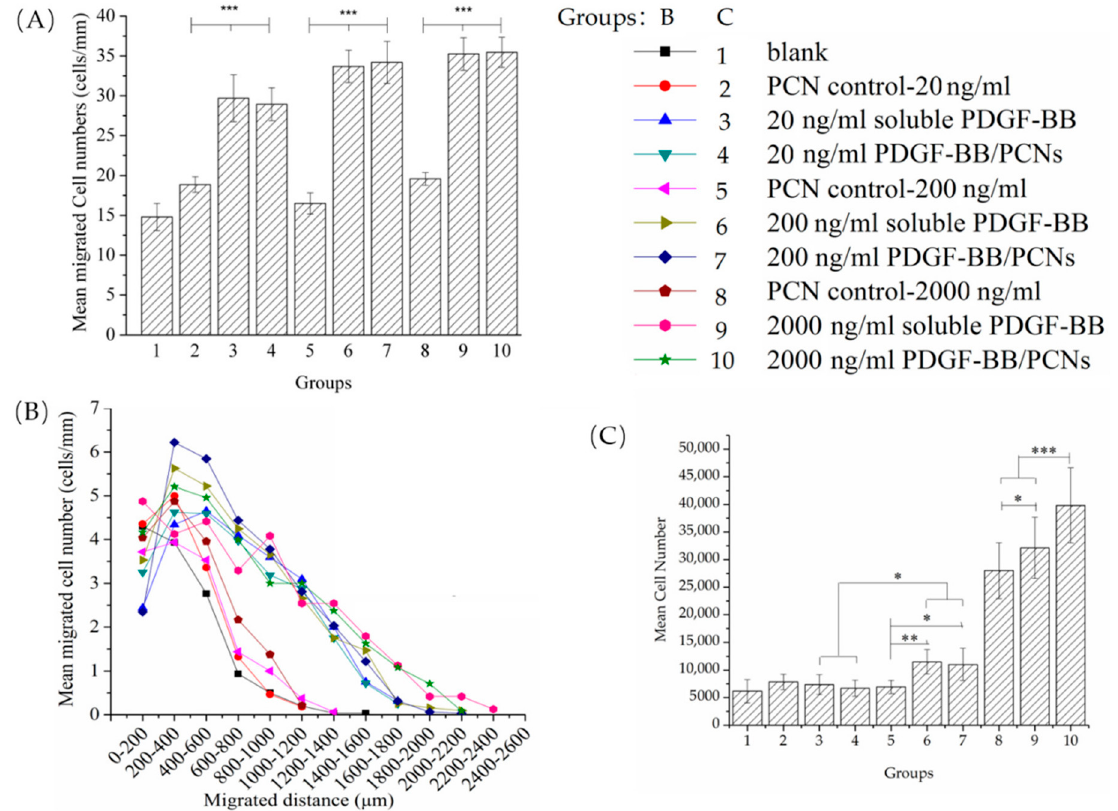
Figure 7. ( A ) Mean migrated cell numbers/mm of interface under the attraction of 20, 200 and 2000 ng/mL PDGF-BB, directly in gel or in PCNs; ( B ) Migration distance under different doses of PDGF-BB. ( n = 6~8; *** p < 0.001). ( C ) Cell numbers after 7 days culture with different doses of PDGF-BB. ( n = 6, * p < 0.05, ** p < 0.01, *** p <